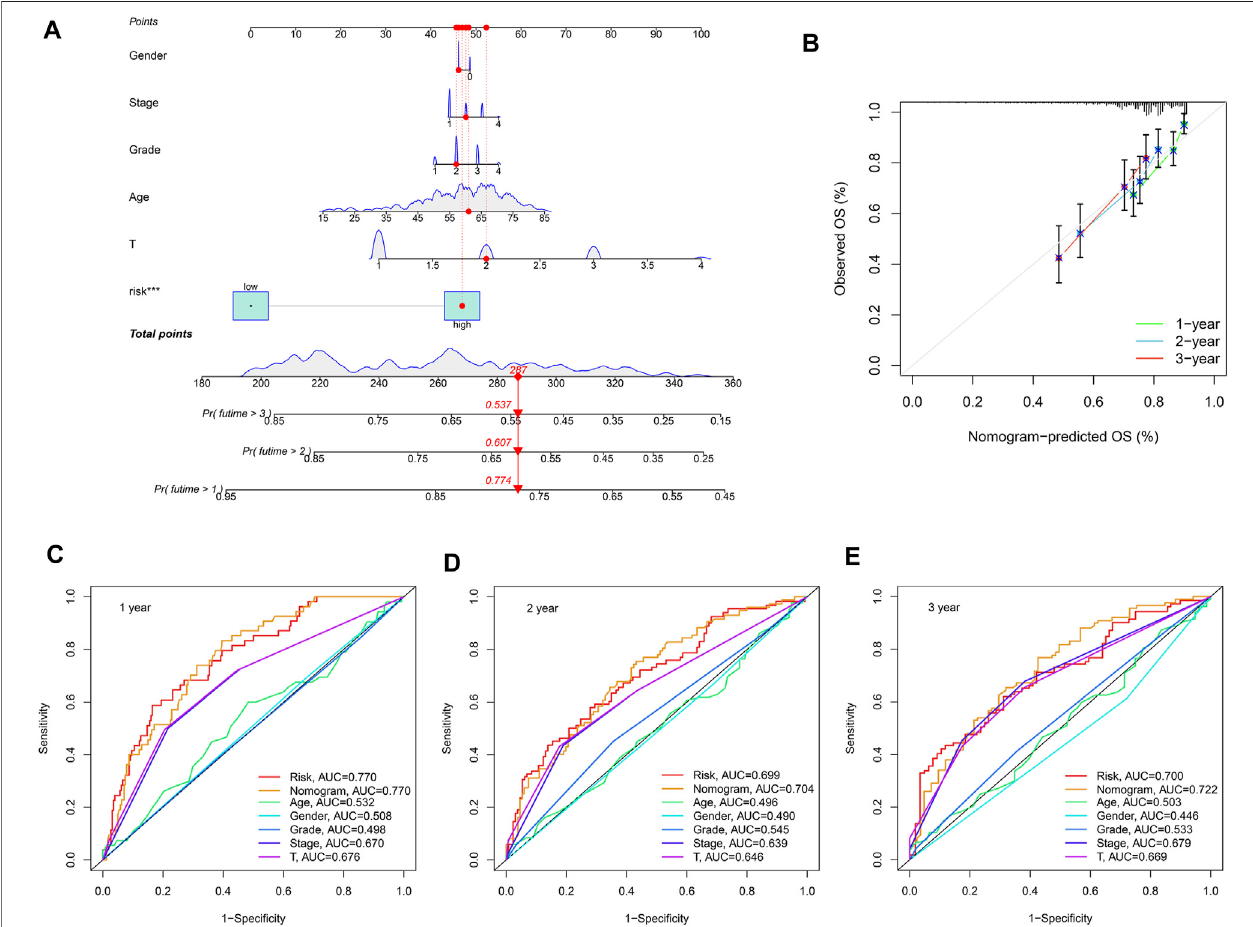
FIGURE 8 | Construction of the nomogram. (A) The 1-, 2-and 3-years survival rates predicted by Nomogram were 0.774, 0.607, and 0.537, respectively. (B) The Calibration curve showed thatthe survival ratepredictedby nomogram isconsistent. (C – E) multiple ROC results showed that riskscore and the nomogram were better than Age, Gender, Grade, Stage, and T Stage in predicting HCC patients ’ survival, which re fl ects the robustness of risk score and nomogram.